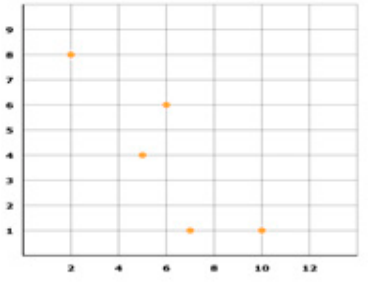
Figure 4. The graph by Figure 3. Frequency of number of likes.